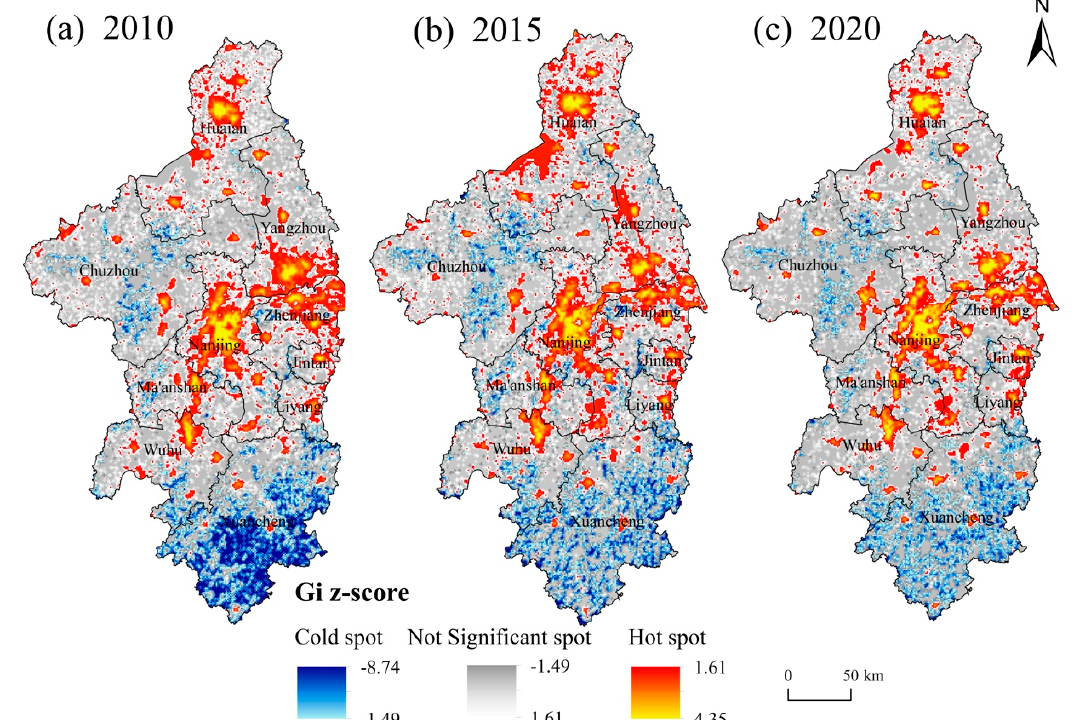
Figure 7. Cold − hot spot map of ecological-economic space conflict for 2010 − 2020. ( a ) 2010 cold − hot spot map; ( b ) 2015 cold − hot spot map; ( c ) 2020 cold − hot spot map.